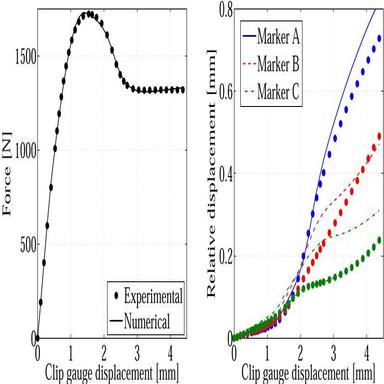
Mechanical response using VGM model for the best fitting of force f F .